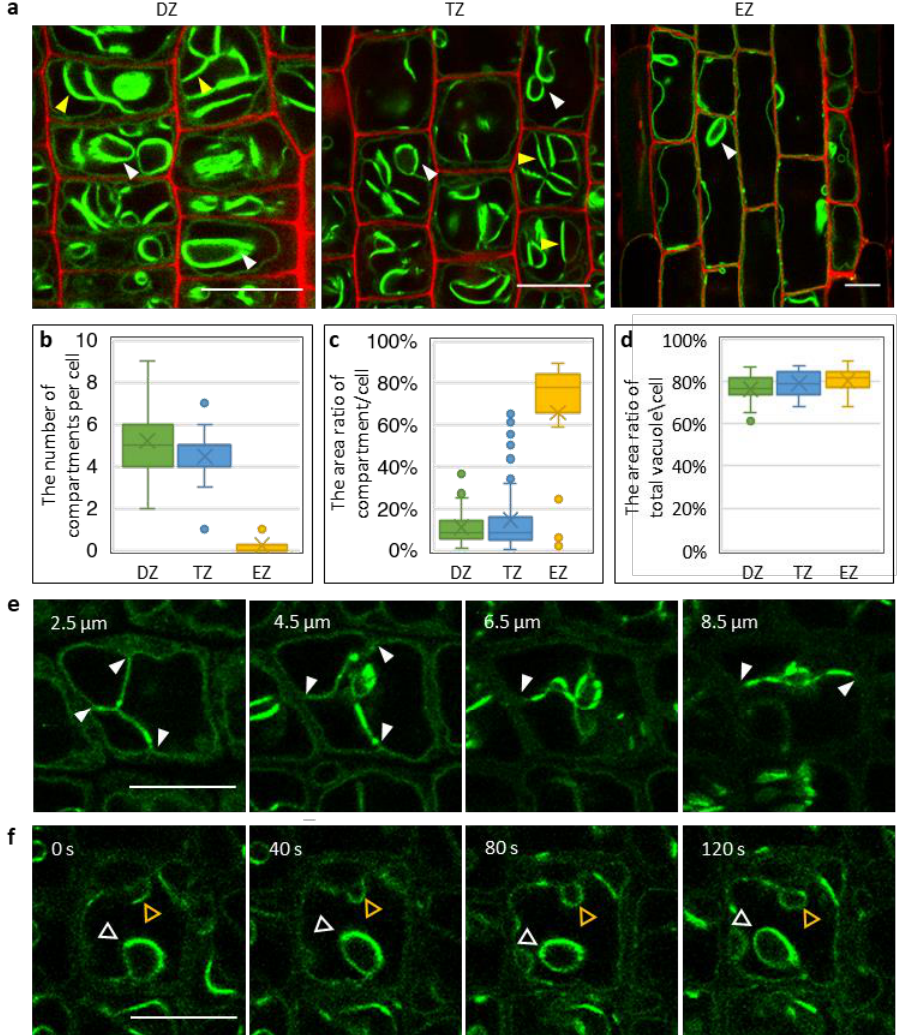
Figure 5. Vacuoles in rice lateral root epidermis are continuous structures with multiple invaginations. ( a ) Vacuole (in green) morphology in different lateral root zones. The cell boundary was stained with propidium iodide (in red). White triangles indicate bubble-like structures, while the yellow triangles indicate strand-like structures. Both are thought to be formed by tonoplast invaginations. ( b ) The number of invaginations in each cell decreased from DZ to EZ. ( c ) The area ratio between segmented vacuoles to cell surface/boundary. The area ratio increased from DZ to EZ. ( d ) The area ratio of total vacuole to cell surface. Further explanation to these measurements is indicated in Figure S5e. Each box is the result of more than 15 cells in three roots. ( e ) Vacuole morphology via z-stacks by confocal microscope with step size of 0.5 µm. The numbers indicate the distance below the cell surface. The arrow heads indicate invagination sites at the boundary membrane. ( f ) Time-lapse images tracking the dynamics of the vacuole invaginations. The orange triangles follow a change from a strand-like structure to a bubble-like structure. The white triangles track the movement of a bubble-like structure. Scale bars: 10 µm.